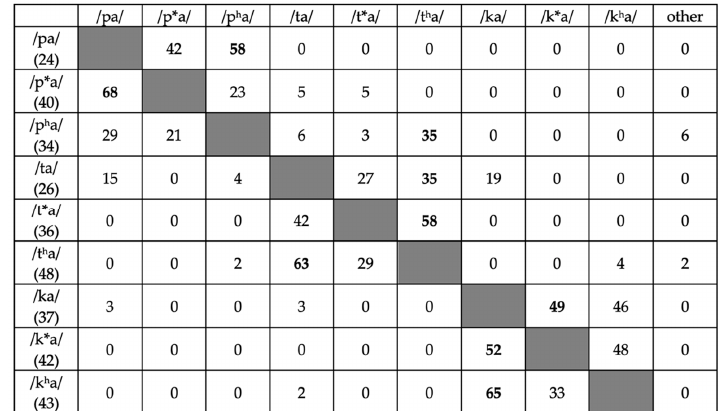
Figure A2. Confusion matrix of errors by the short ‐ long group in the posttest for stop items (vertical = stimuli, horizontal = responses). Each cell shows the percent of all errors on the given stimulus represented by the given response (rows may not add to 100% due to rounding); the most common error type for each stimulus is bolded. The total number of errors for each stimulus (across all participants in the group) is shown in parentheses.